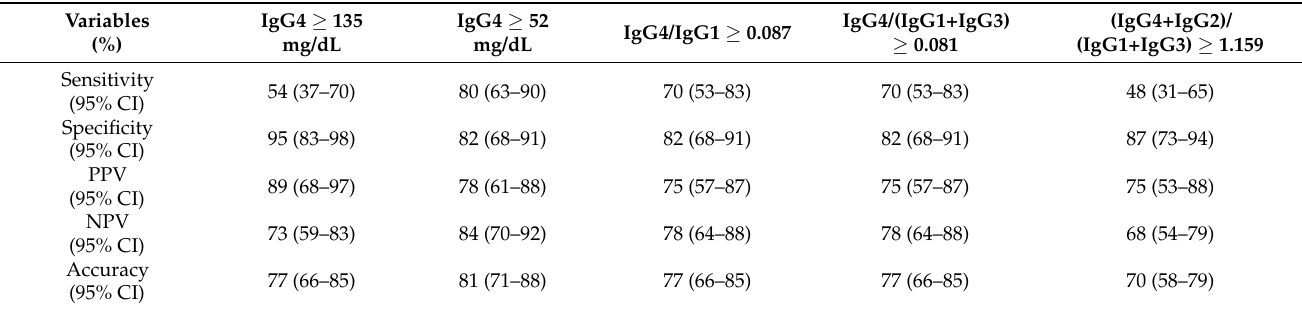
Table 3. Performance of the serum IgG subclass combinations for the differentiation of IgG4-SC from